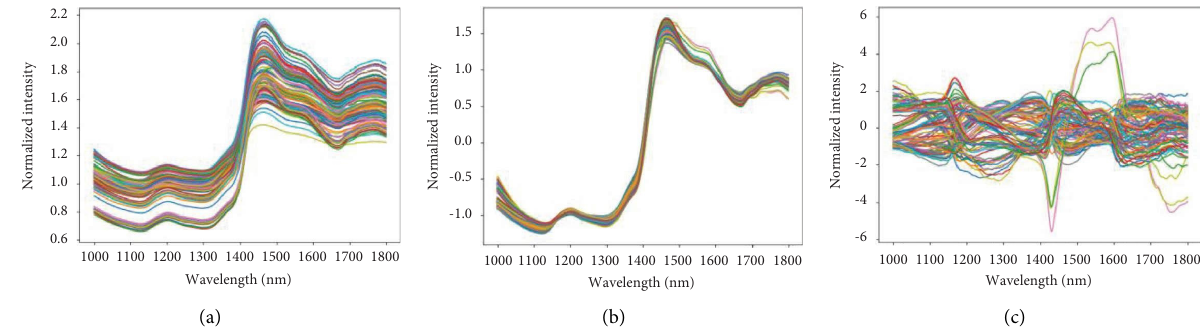
Figure 2: Normal spectra and the spectra after pretreatment of Antai pill samples: (a) original spectra, (b) spectra after SG and SNV treatment, and (c) spectra after data standardization.